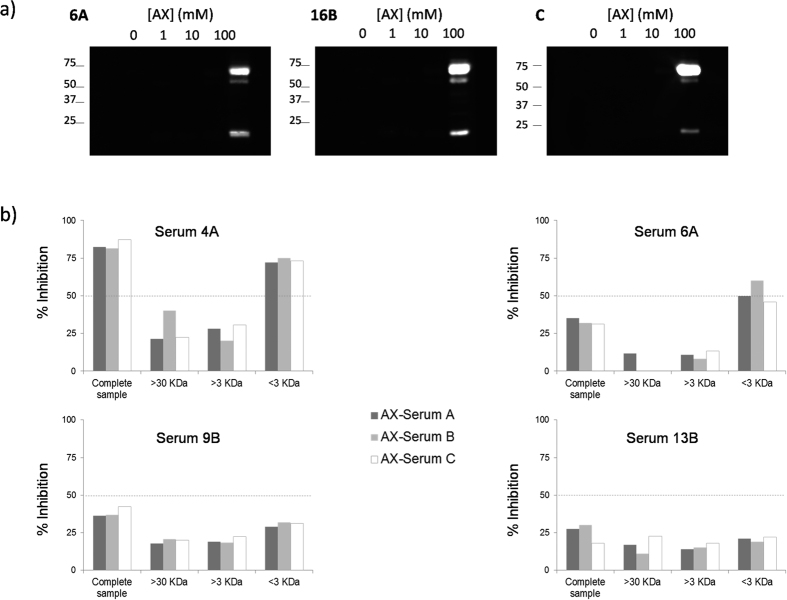
Detection of serum proteins modified with AX and study of their IgE recognition.(a) Immunological detection by Western blot of serum proteins modified with AX during inhibition RAST procedure. Three representative cases from a selective allergic patient to AX (6A), a cross-reactive patient to penicillins (16B) and a healthy control C are shown. (b) RAST inhibition assays of different serum samples (4A, 6A, 9B and 13B) from AX allergic patients. Solid-phase: cellulose discs modified with AXO-PLL. Inhibitors: Different fractions (complete sample (CS), fraction with components of molecular weight higher than 30 KDa (FC > 30), fraction with components of molecular weight higher than 3 KDa (FC > 3), fraction with components of molecular weight lower than 3 KDa (FC < 3)) of three AX-modified-sera (from group A, B and tolerant control) at protein concentration 1 mg/mL for CS, FC > 30 and FC > 3, and at the same dilution as FC > 3 for FC < 3). Results are expressed as percentage of inhibition.